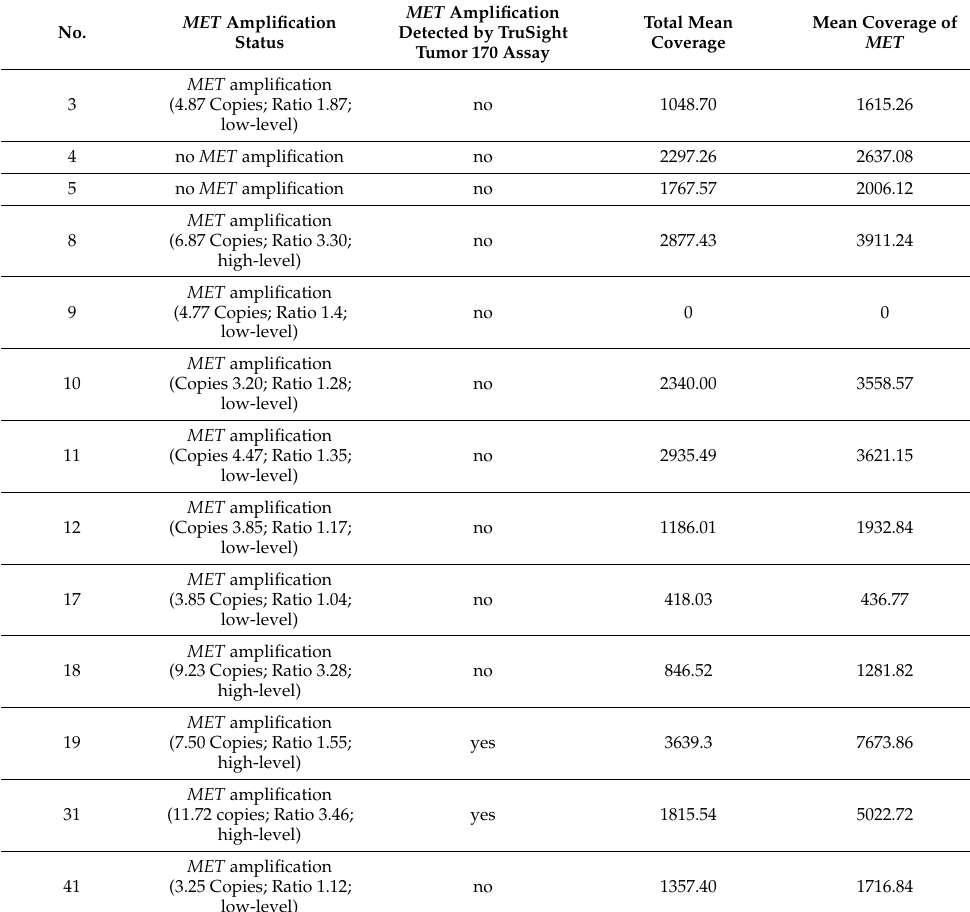
Table 3. Total mean coverage and mean coverage of MET of the 11 MET amplified samples as well as the two samples without MET